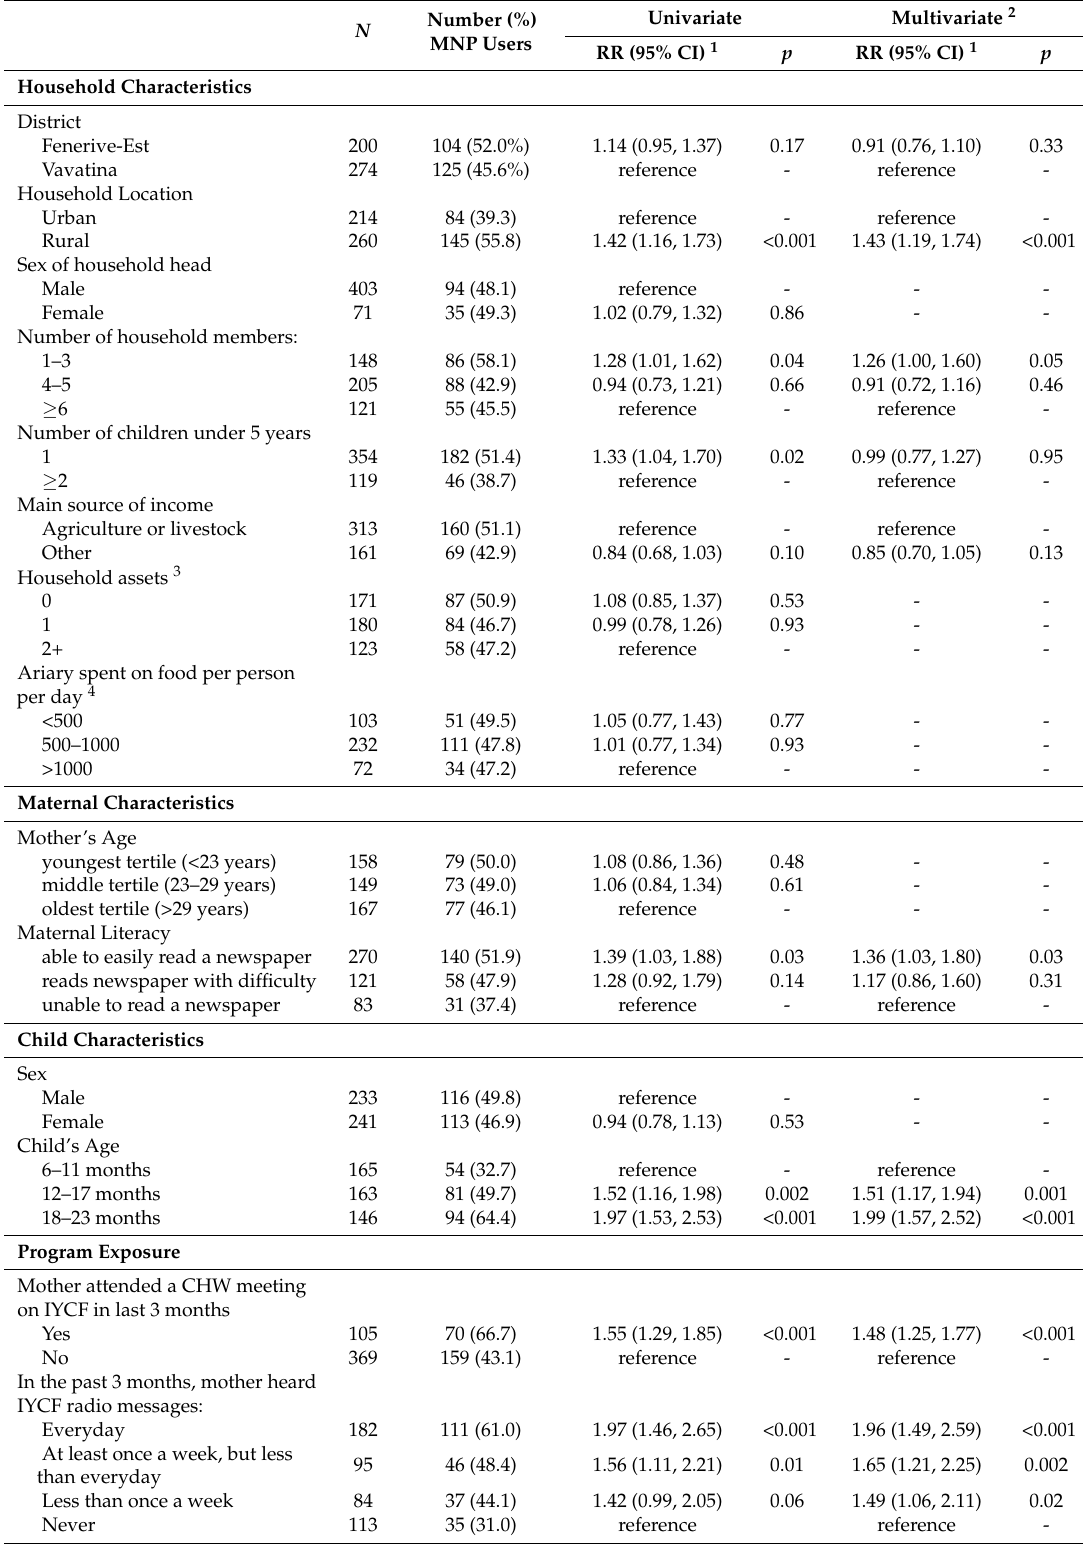
Table 4. Predictors of MNP